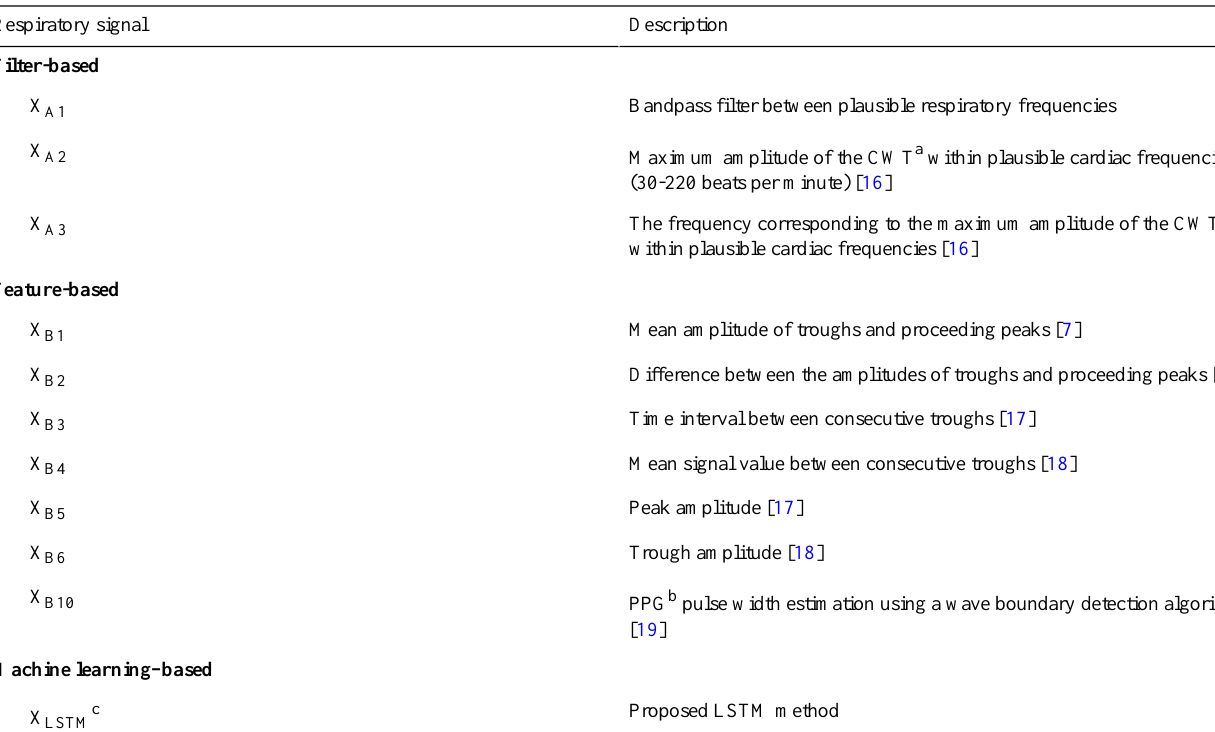
Table 1. Techniques for the extraction of respiratory signals from a photoplethysmogram (adapted from Charlton et al [15]). DescriptionRespiratory